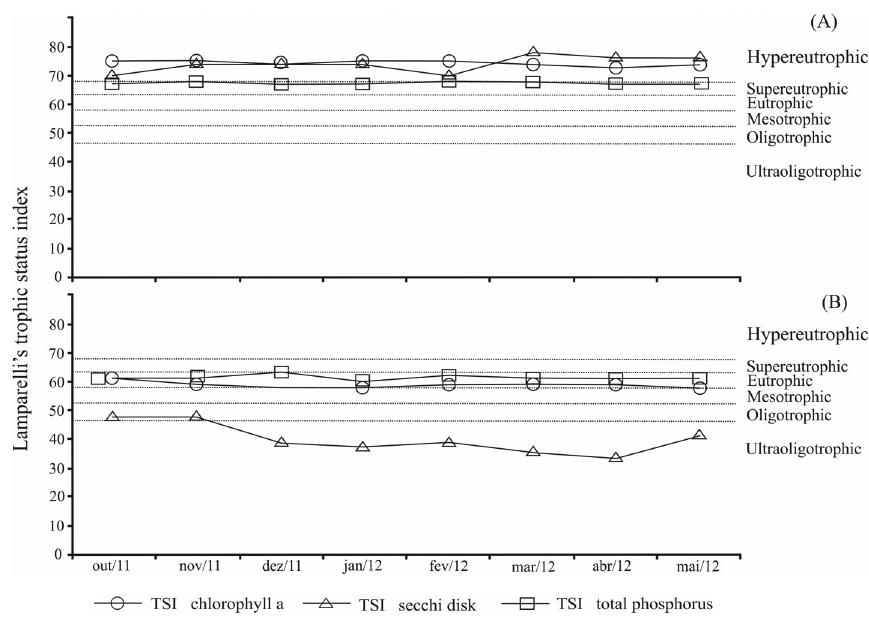
Figure 4. Temporal variation of the Trophic State Index (TSI) proposed by Lamparelli (2004) in Pau dos Ferros (A) and Santa Cruz do Apodi (B) reservoirs. (Ultraoligotrophic TSI = ≤ 47; Oligotrophic = 47 <TSI ≤ 52; Mesotrophic = 52 <TSI ≤ 59; Eutrophic = 59 <TSI ≤ 63; Supereutrophic = 63 <TSI ≤ 67; Hypereutrophic I TS => 67).